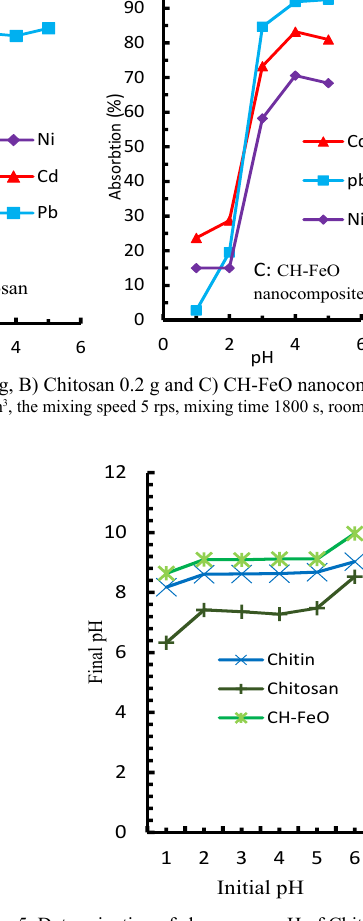
Fig. 5. Determination of charge zero pH of Chitin, Chitosan and CH-FeO nanocomposite The experiment conditions: 20 dm 3 solution, initial ion concentrations 10 mg/dm 3 , the mixing speed 5 rps, mixing time 1800 s, room temperature